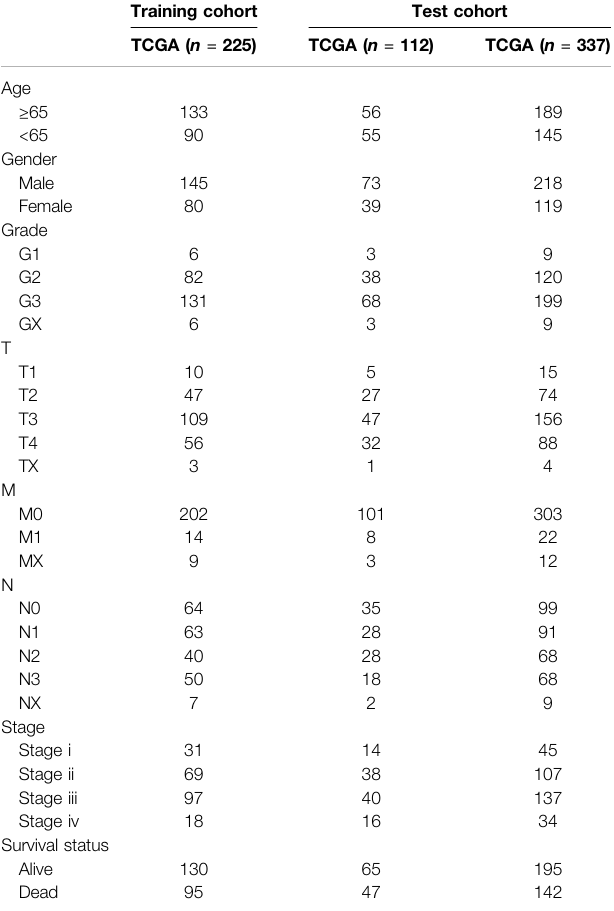
TABLE 1 | Clinicopathologic characteristics of patients with STAD in the training cohort and two test cohorts. Training